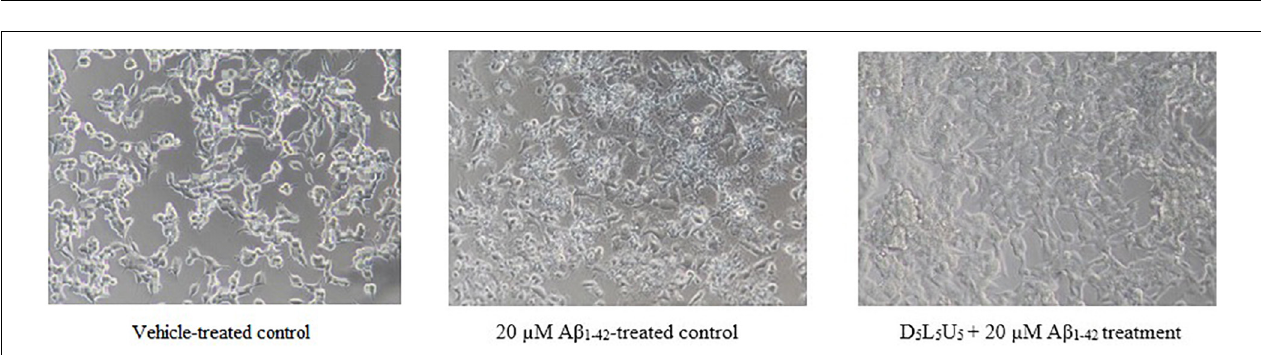
FIGURE 4 | The effect of D 5 L 5 U 5 on A β 1 - 42 -induced toxicity. (A) % cell viability (B) % LDH release determined from MTS and LDH assays, respectively, with pre-treatment of D